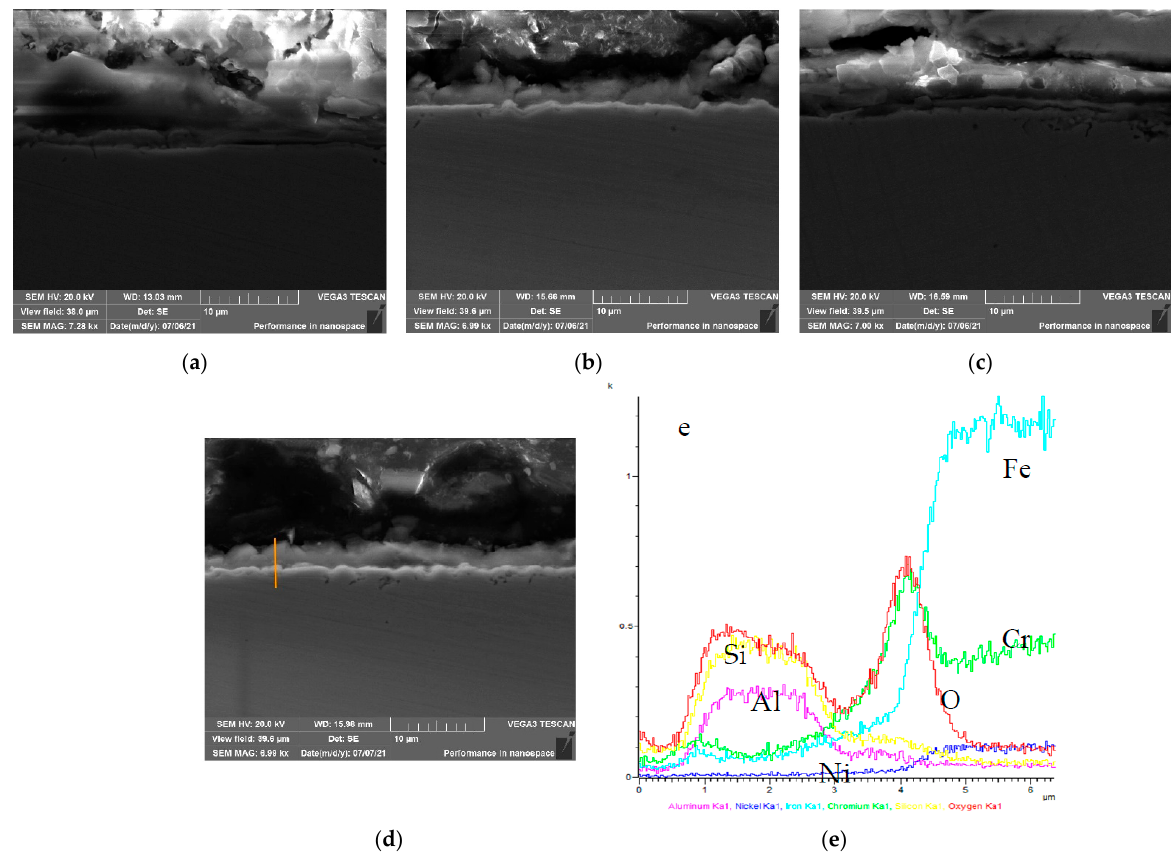
Figure 2. Cross section morphology and EDS of mullite film samples with different layers after sintering: ( a ) single-layer; ( b ) three-layer; ( c ) six-layer; ( d ) nine-layer; ( e ) EDS line scan of the yellow line in ( d ).